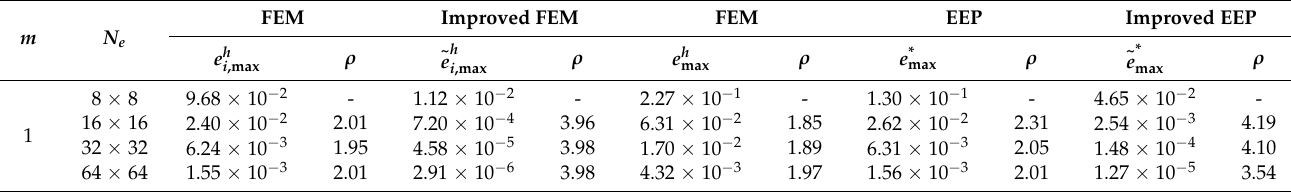
Table 2. Convergence orders of displacement component in x